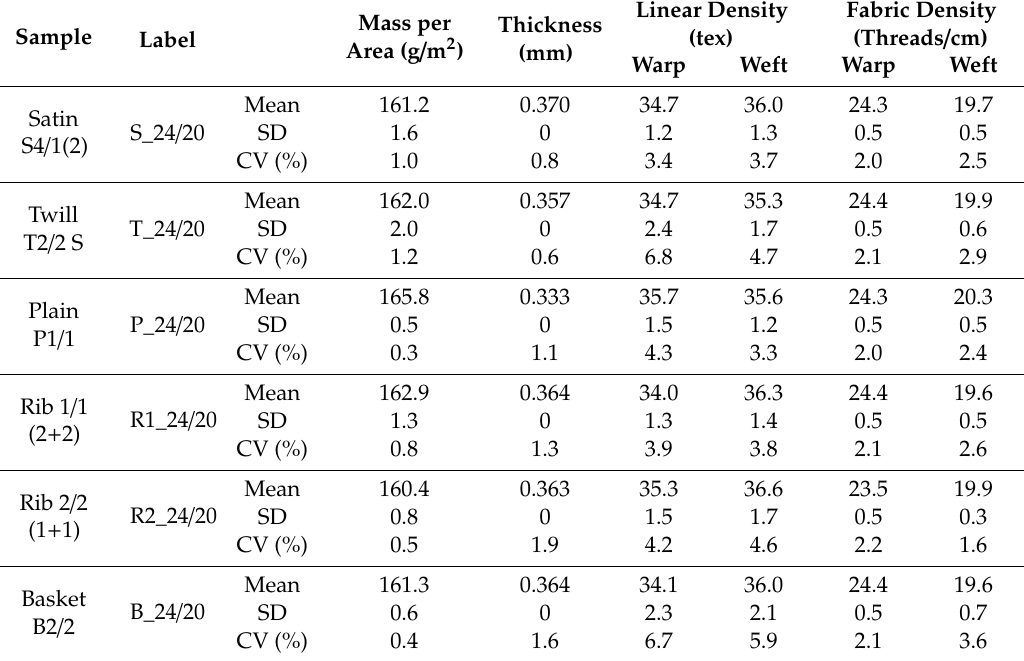
Table 3. Constructional / physical parameters of samples with density 24 / 20 threads / cm.